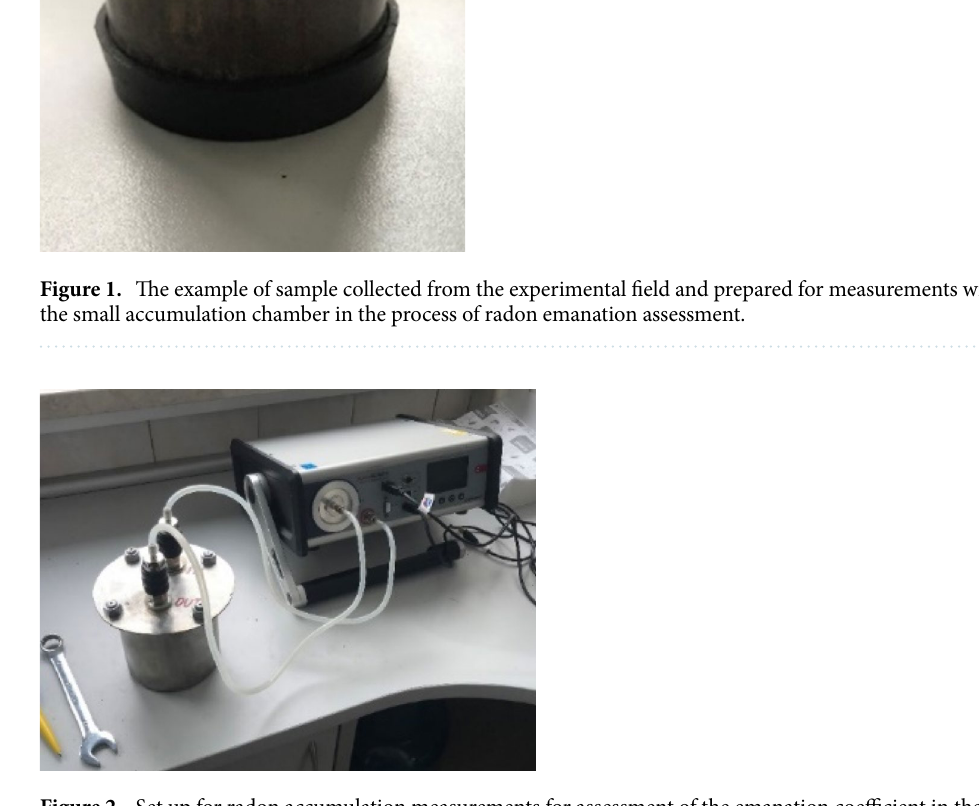
Figure 2. Set up for radon accumulation measurements for assessment of the emanation coefficient in the laboratory environment. Set include the small accumulation chamber with the total volume of 0.00114 m 3 (present on the left side) operating with the AlphaGuard instrument (presented on the